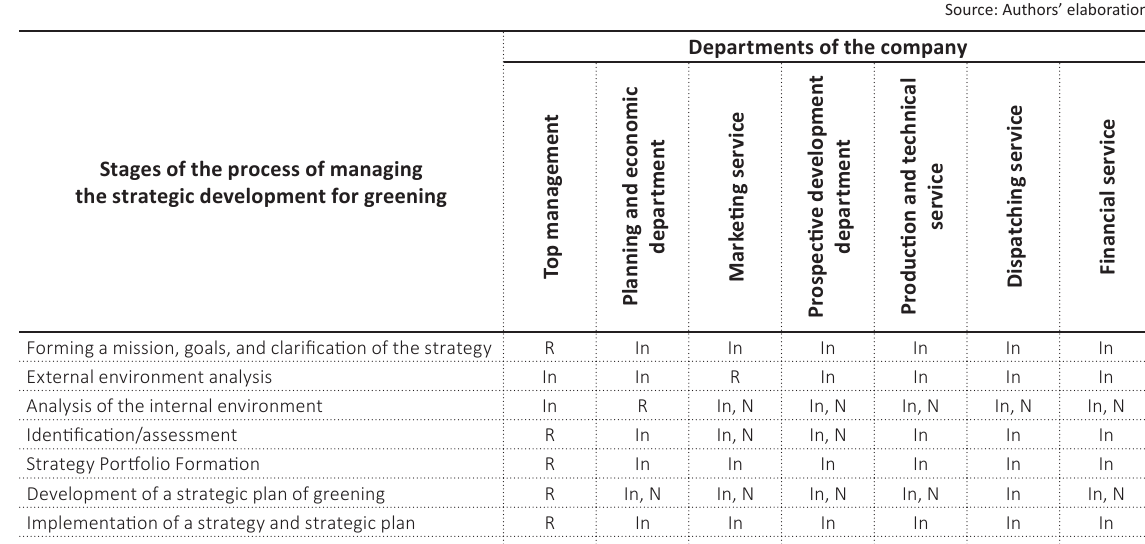
Table 5. Flexible delegating map of authority between departments of a company on the forming of a greening strategy